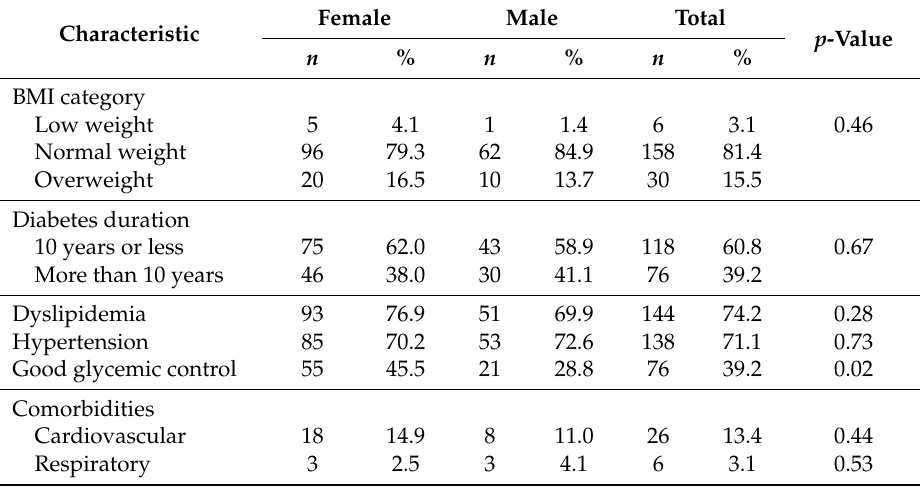
Table 2. Health characteristic of elderly patients with type 2 diabetes mellitus